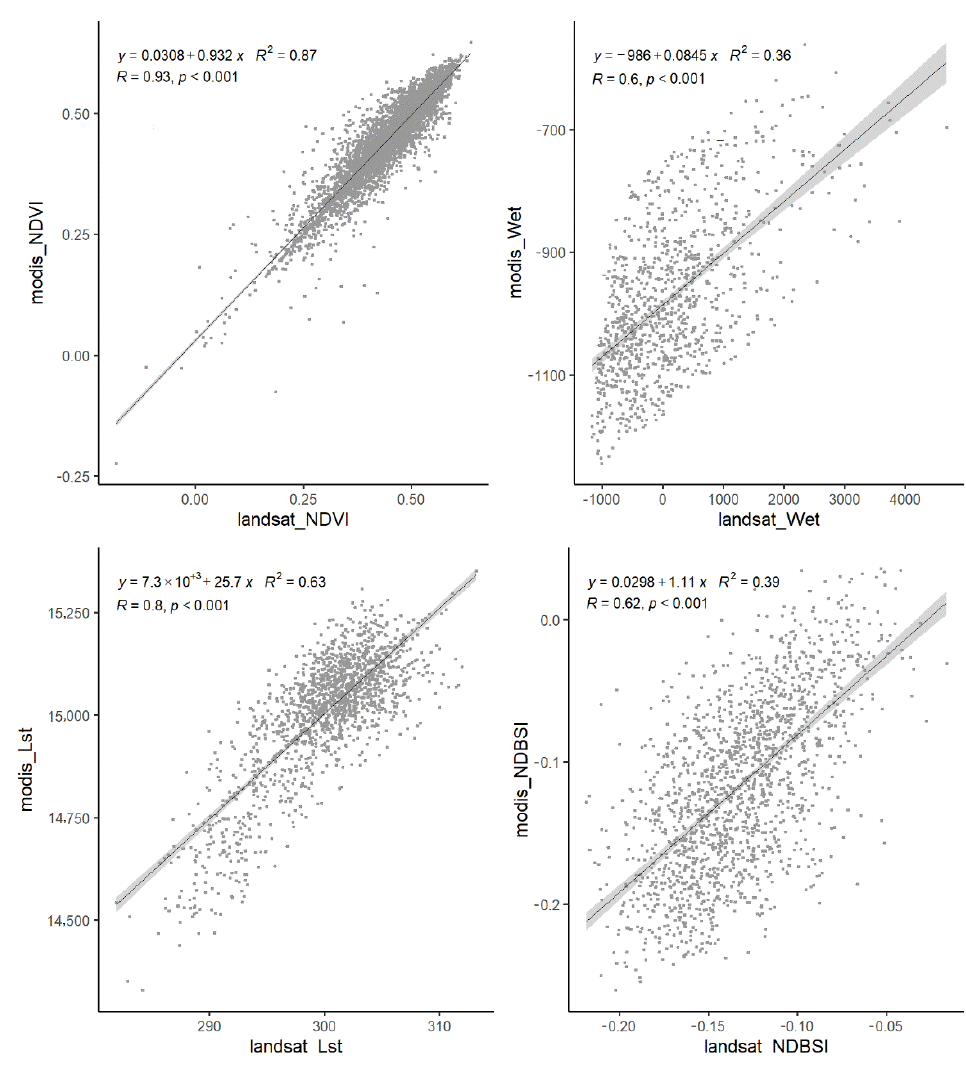
Figure 2. Precision verification of indicators (NDVI, Wet, Lst, NDBSI) . Table 2. Indicators and their weights of EI